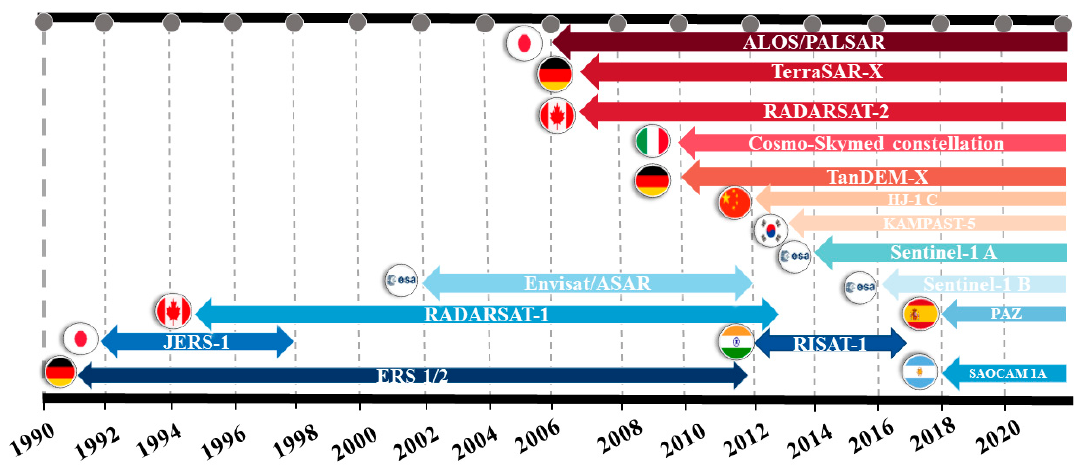
Figure 8. The launch and end mission dates of the major SAR sensors. The last column represents the present time.